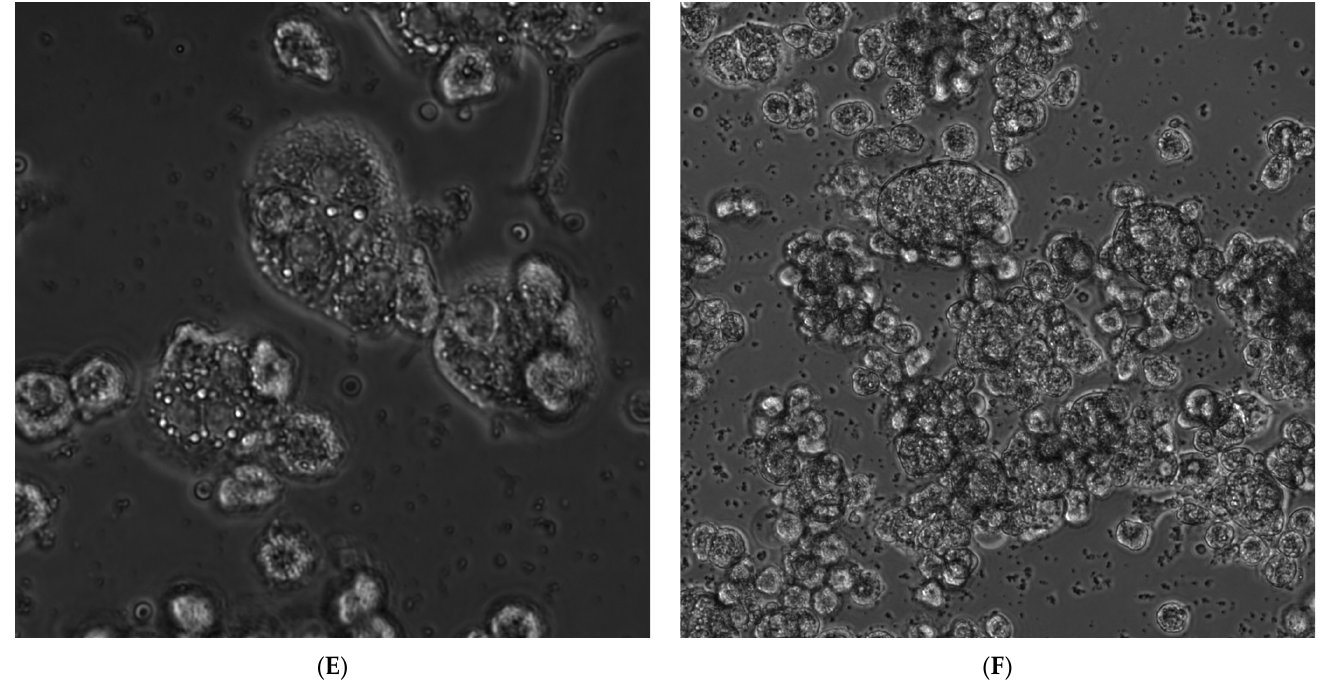
Figure 5. Culture of primary hepatocytes after incubation for 6 h ( A , C , E ) and 24 h ( B , D , F ) with NC(Cu-PVI) ( C , D ) and CuAc 2 ( E , F ). ( A , B ) Control samples. Magnifications are 40× ( A – E ), 20× ( F ).